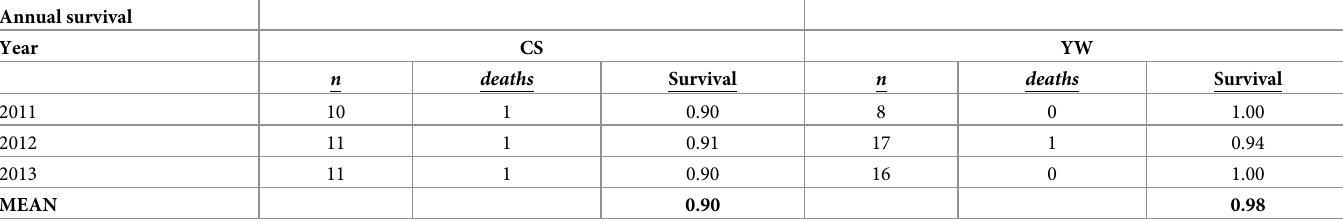
Table 1. Annual survival for female desert tortoises. Female tortoises were monitored using radio-telemetry over a three-year period in creosote scrub (CS) and yucca woodland (YW) habitats in Mojave National Preserve, California, USA. Annual survival